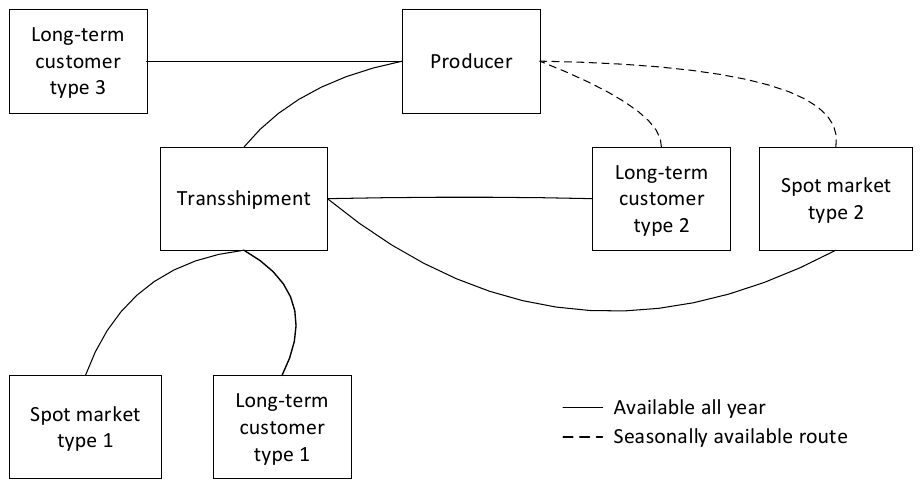
Figure 2. Illustration of the LNG